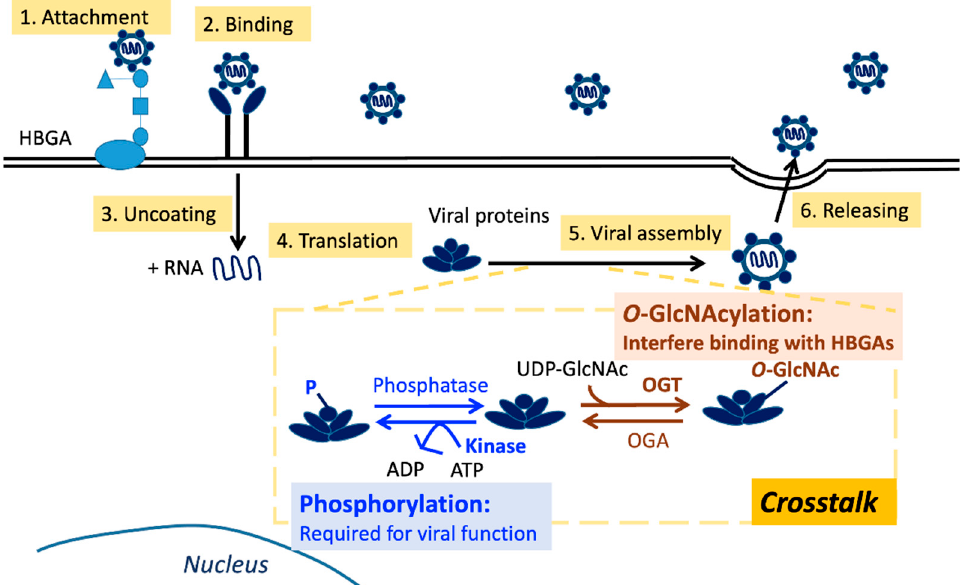
Figure 2. Replication cycle of noroviruses and post-translational modification crosstalk between phosphorylation and O -GlcNAcylation. Co-occurring PTMs on proteins are common, and PTM crosstalk between phosphorylation and O -GlcNAcylation is the most common since they will compete for the same residues (serine/threonine residues). Phosphorylation is required for viral function. In contrast, O -GlcNAcylation of norovirus capsid protein VP1 could interfere with receptor binding. Studies on the O -GlcNAcylation of noroviruses are few and lack direct evidence from